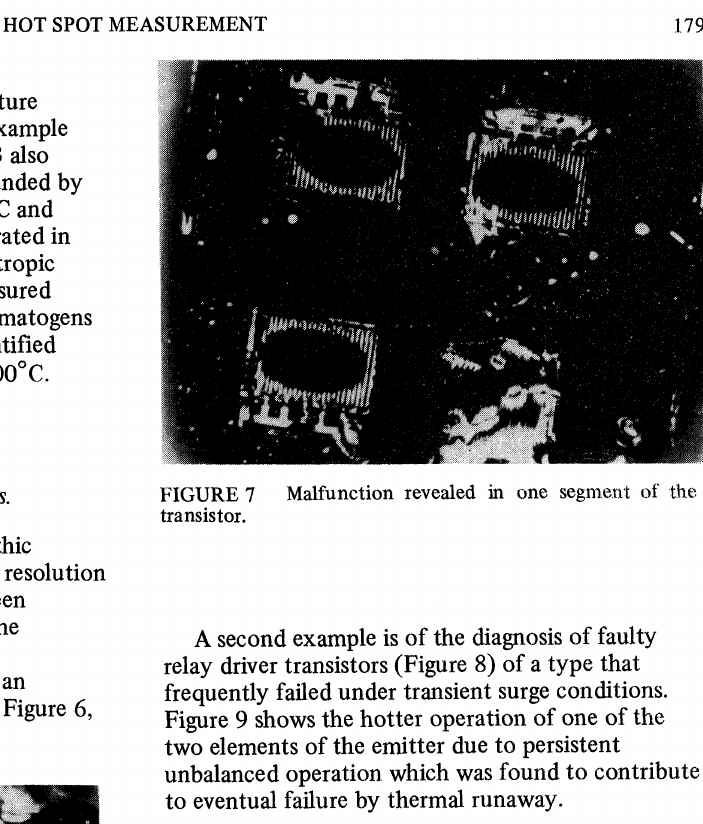
Hotter regions of one segment of an inter- digitated transistor.